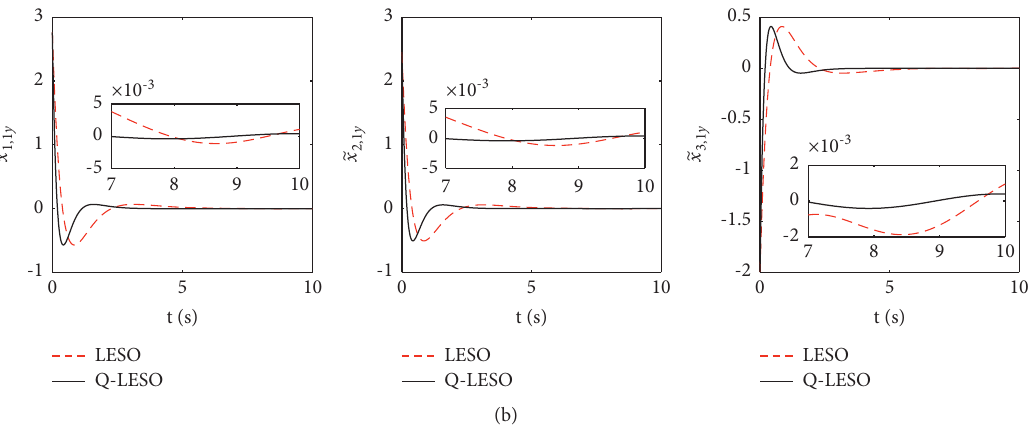
Figure 10: The position estimation error 􏽥 x i, 1 in Case B(a) The position estimation error of the x -direction of the i th agent i position estimation error of the y -direction of the i th agent i � 1, 2, 3.